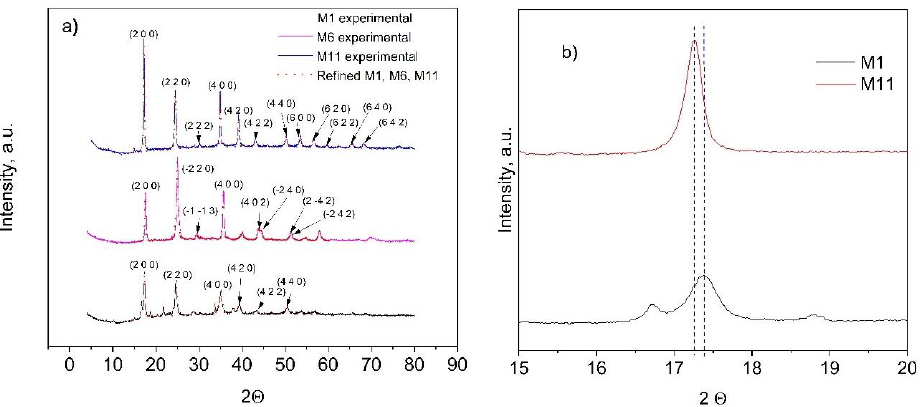
Figure 4. ( a ) Experimental (dots) and refined (continuous lines) powder X-ray diffraction data results for CoHCFs M1, M6, and M11; ( b ) partial magnification of the 200-lattice plane of M1 and M11 samples. Table 2. Crystallographic data and structure refinement parameters were obtained after the